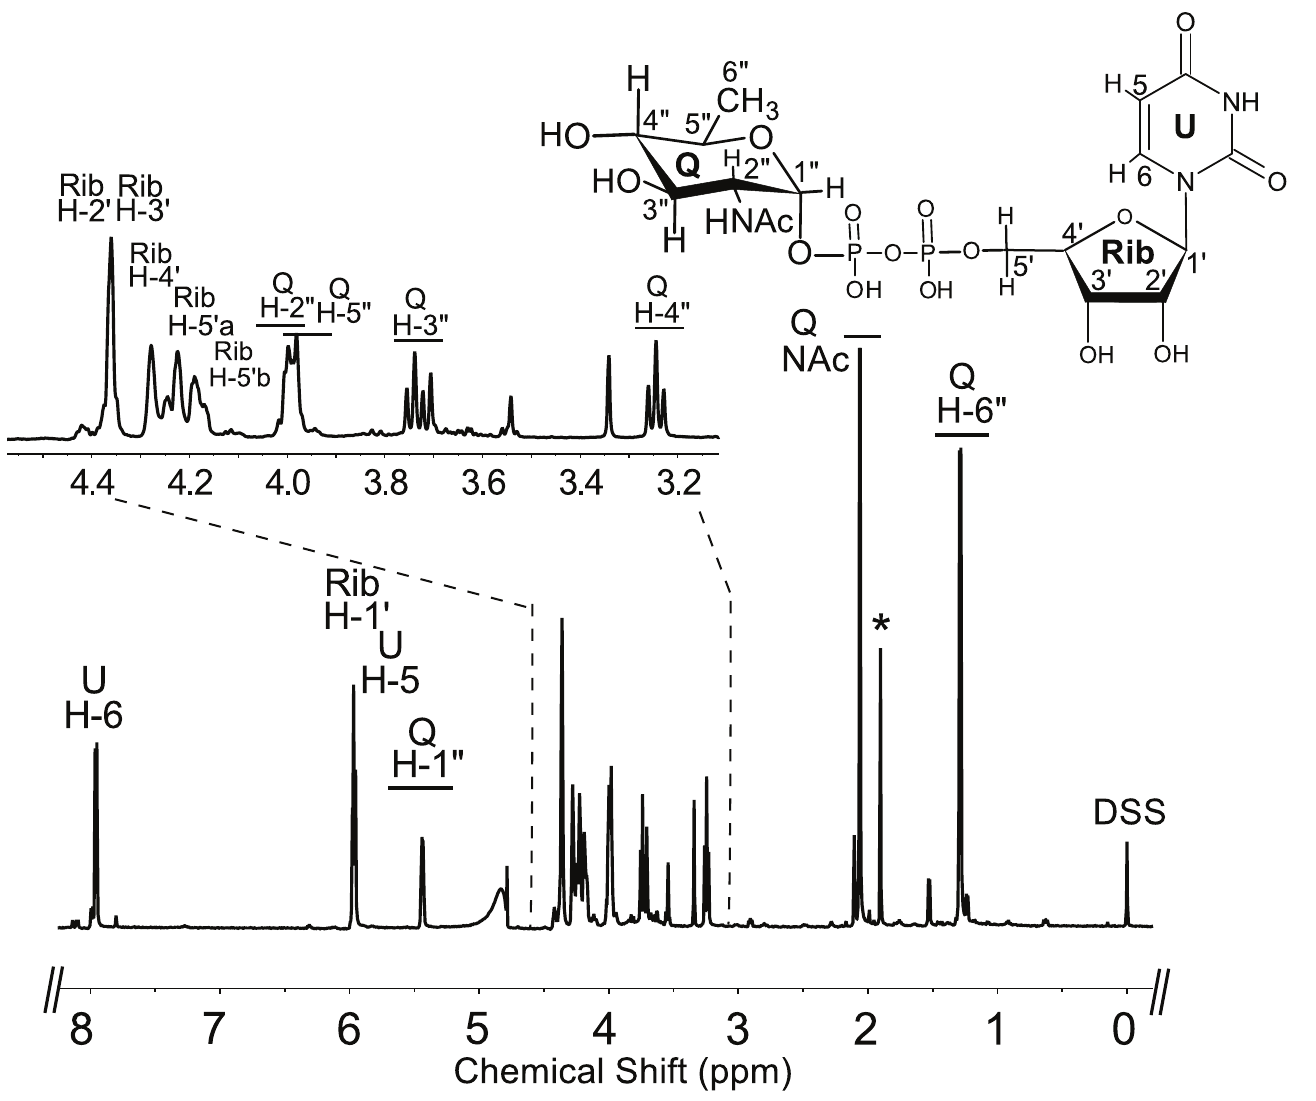
Fig 7. Analysis of Preq reaction product by 1 H-NMR indicates formation of UDP-QuiNAc. The product of the Preq reaction (peak Q, in Fig 6 Panel B) was collected and analyzed at 600 MHz NMR. Full proton spectrum of HPLC-collected product UDP-QuiNAc. Expanded proton spectra between 3.2 and 4.4 ppm that shows the QuiNAc sugar ring. The short line above NMR ‘ peaks ’ denotes specific chemical shifts belonging to a